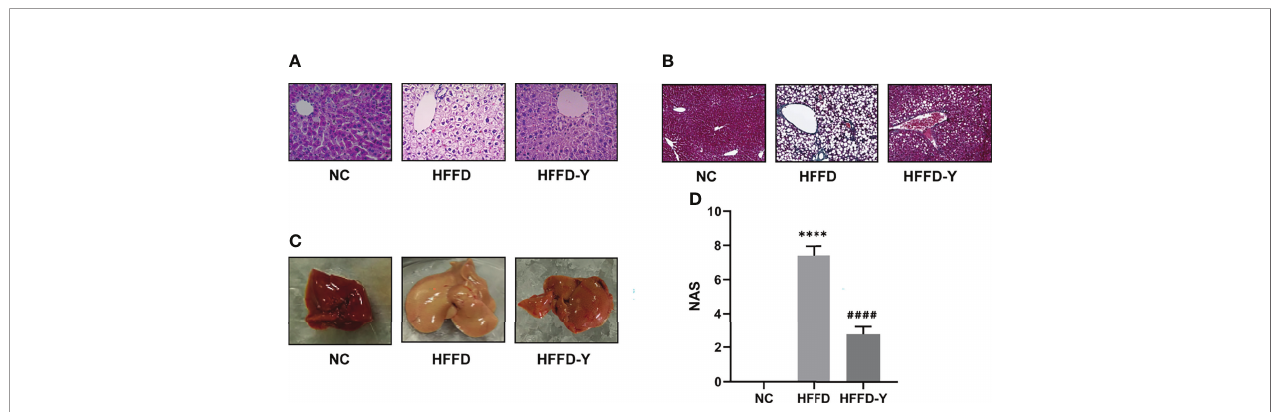
FIGURE 1 | Pathological results of mice. (A) H&E staining results of the mice. (B) Masson staining results of the mice. (C) The photos of the mice ’ s liver. (D) The NAS calculation results of the mice. (**** p <0.0001 vs NC; #### p <0.0001 vs